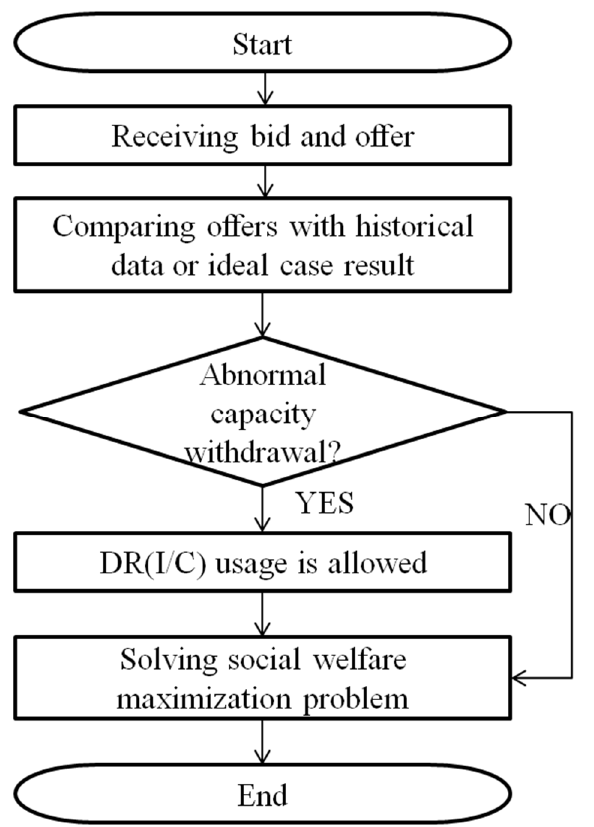
Figure 2. The scheduling process of the method described